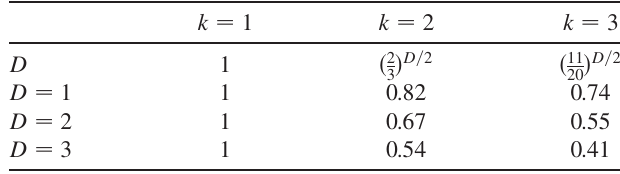
for different order k